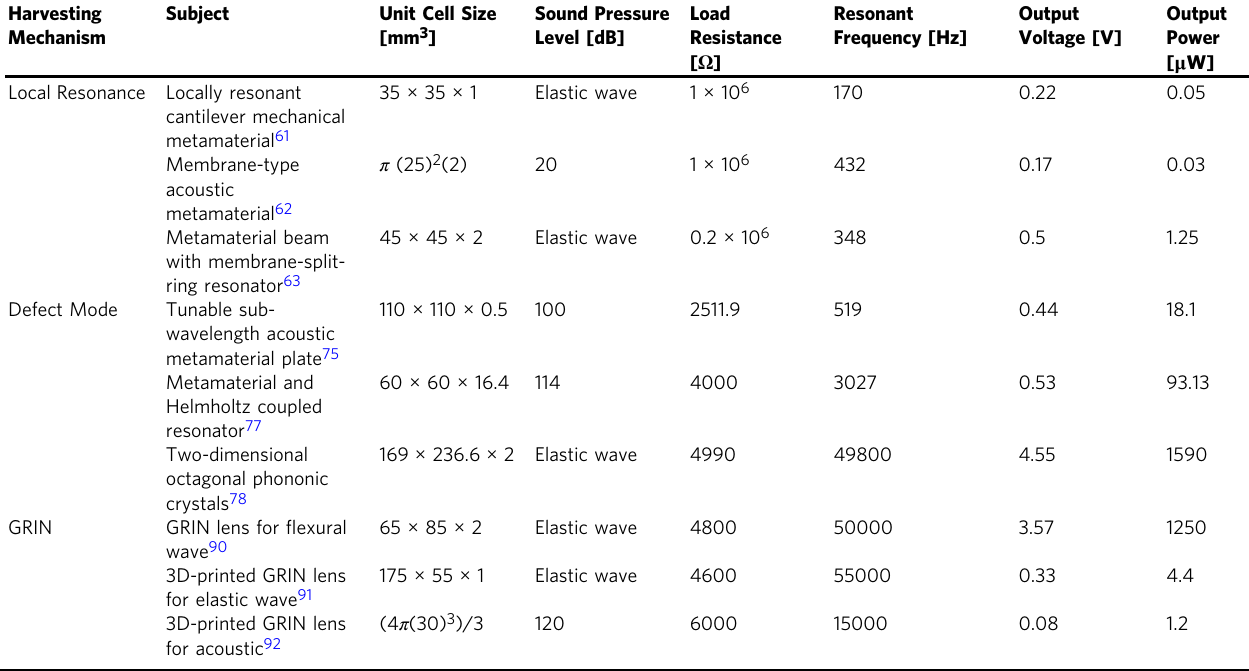
Table 1 Summary of mechanical energy harvesters that use mechanical metamaterials or phononic crystals. Harvesting